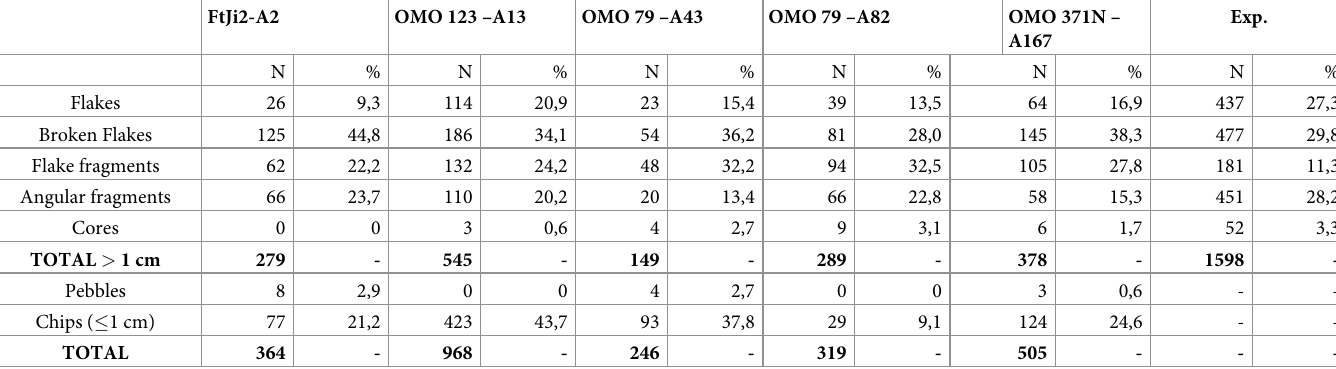
Table 1. Technological composition of the five archaeological assemblages from Member F (Shungura Formation) and experimental assemblage. (NB. “Cores” includes whole and broken cores, “Pebbles” includes whole and broken pebbles). FtJi2-A2 OMO 123 –A13 OMO 79 –A43 OMO 79 –A82 OMO 371N –